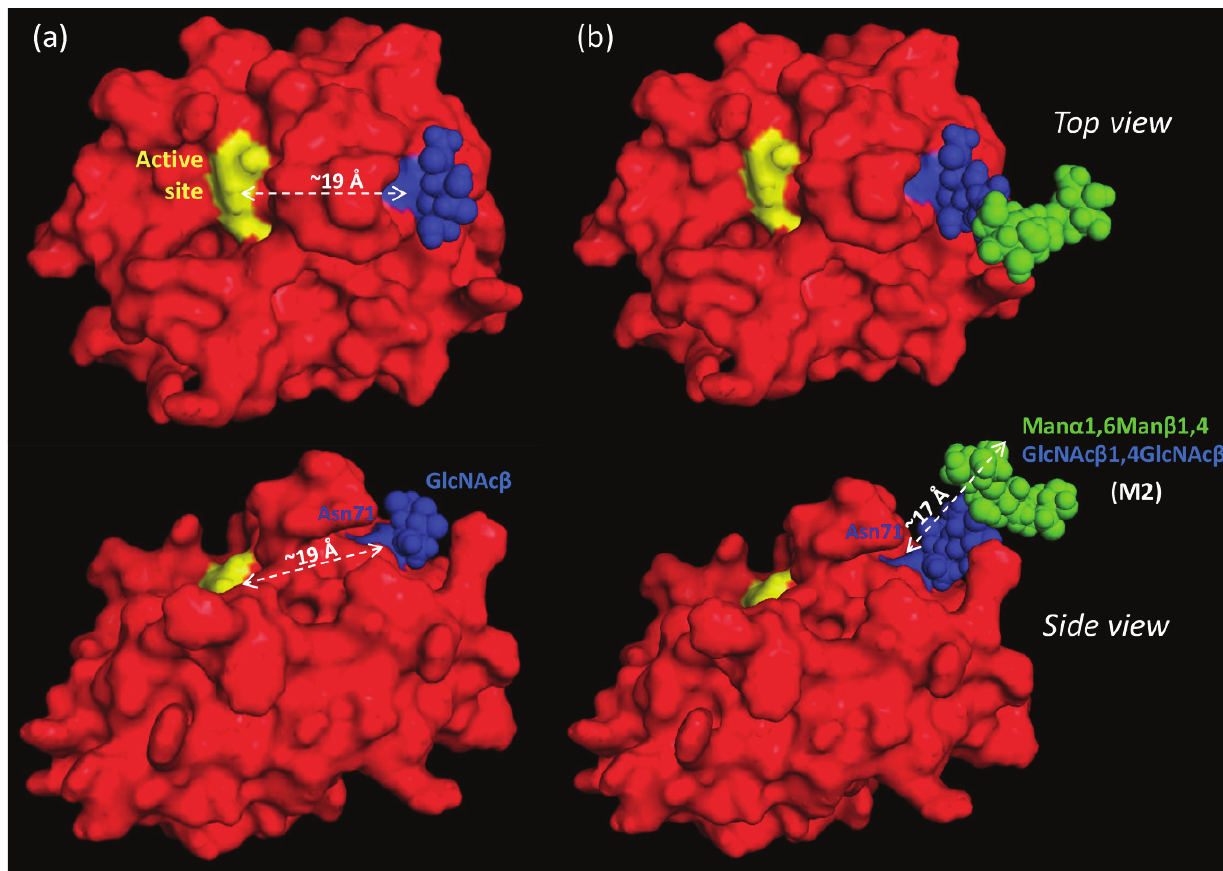
Figure 6. Top and side view of nCG illustrating the proximity (~19 Å) of the active site to the Asn71-glycosylation site conjugated with ( a ) GlcNAc(cid:2) and ( b ) M2 (Man(cid:3)1,6Man(cid:2)1,4GlcNAc(cid:2)1,4GlcNAc(cid:2)). Color scheme: yellow denotes His64, Asp108, and Ser201 forming the active site of nCG; blue denotes the Asn71-glycosylated residue and the conjugated GlcNAc residues; and green denotes mannose residues. The approximate height of the M2 N -glycan (~17 Å) is